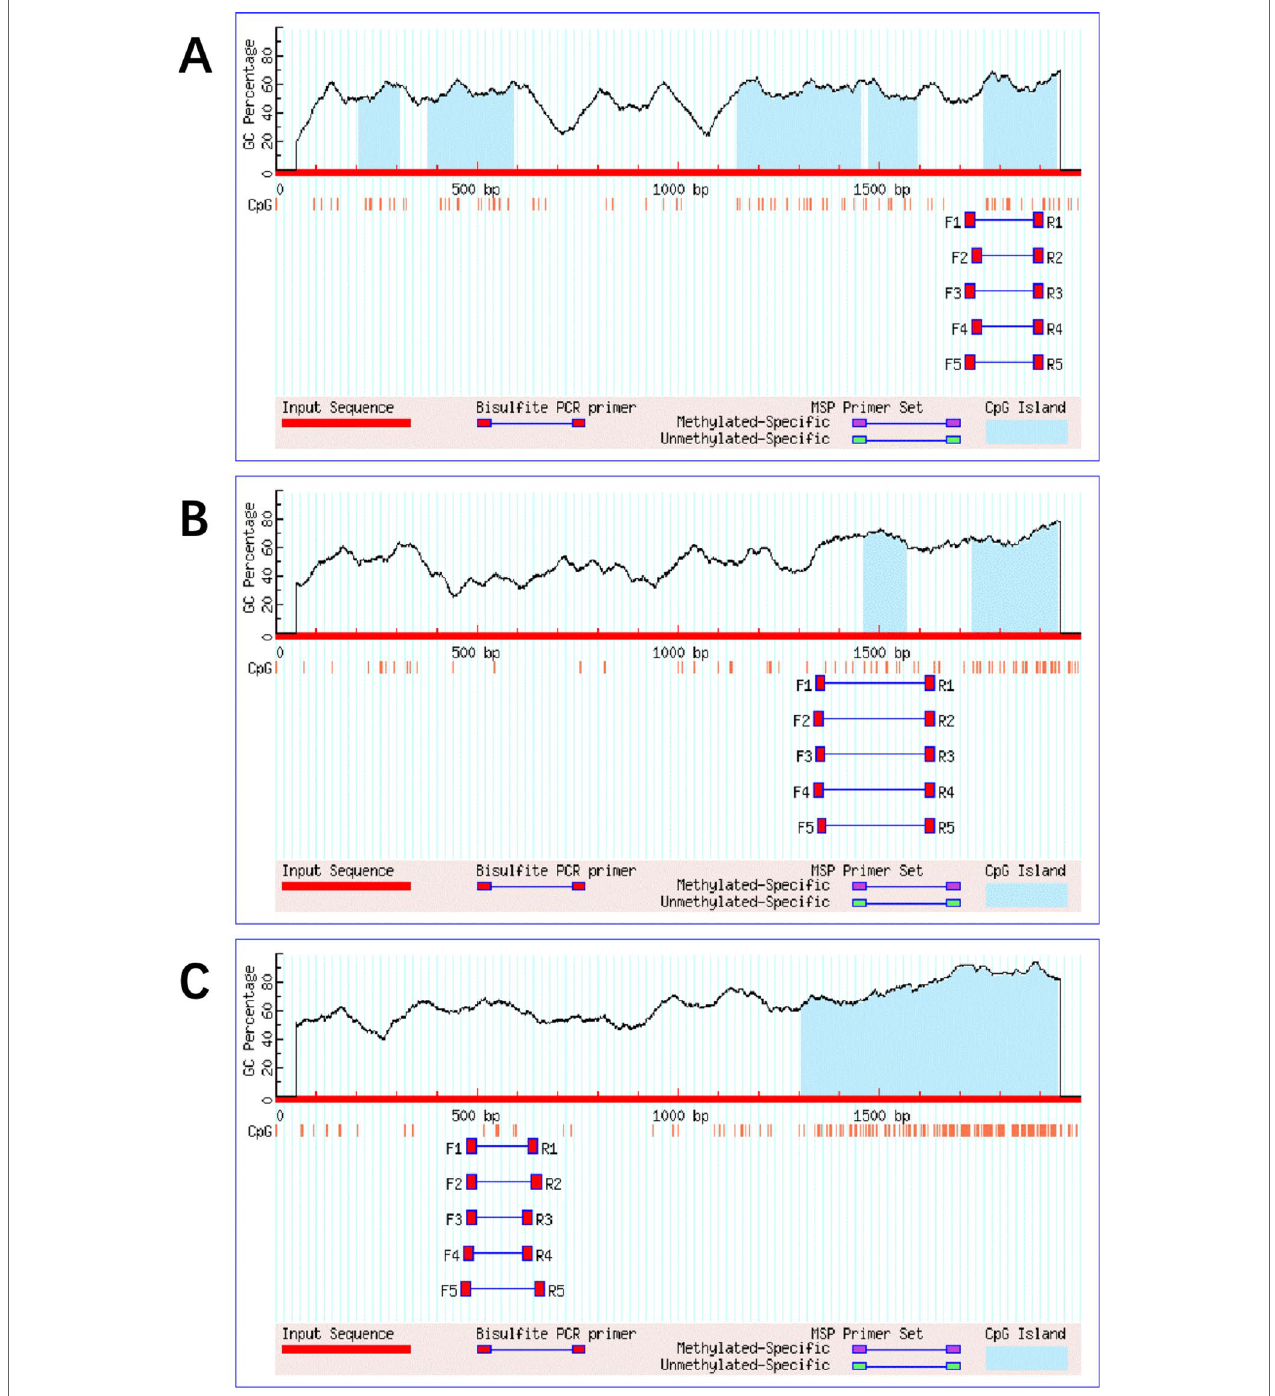
FiGURe 1 | The target sequences' bisulfite transformation and design primers in the promoter regions of genes cGAS/MAVS/TRAF3.